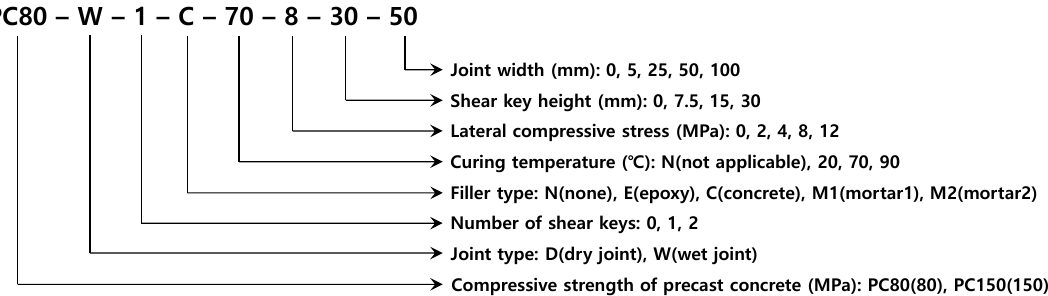
Figure 4. Specimen identification.